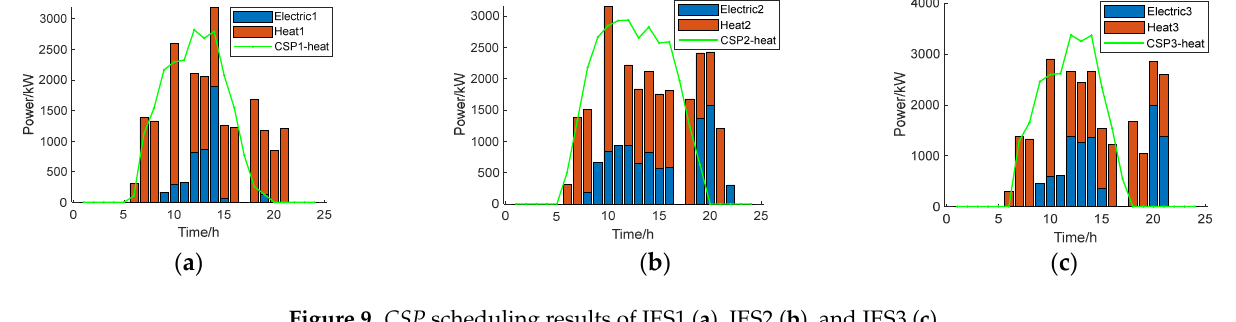
Figure 9. CSP scheduling results of IES1 ( a ), IES2 ( b ), and IES3 ( c ).